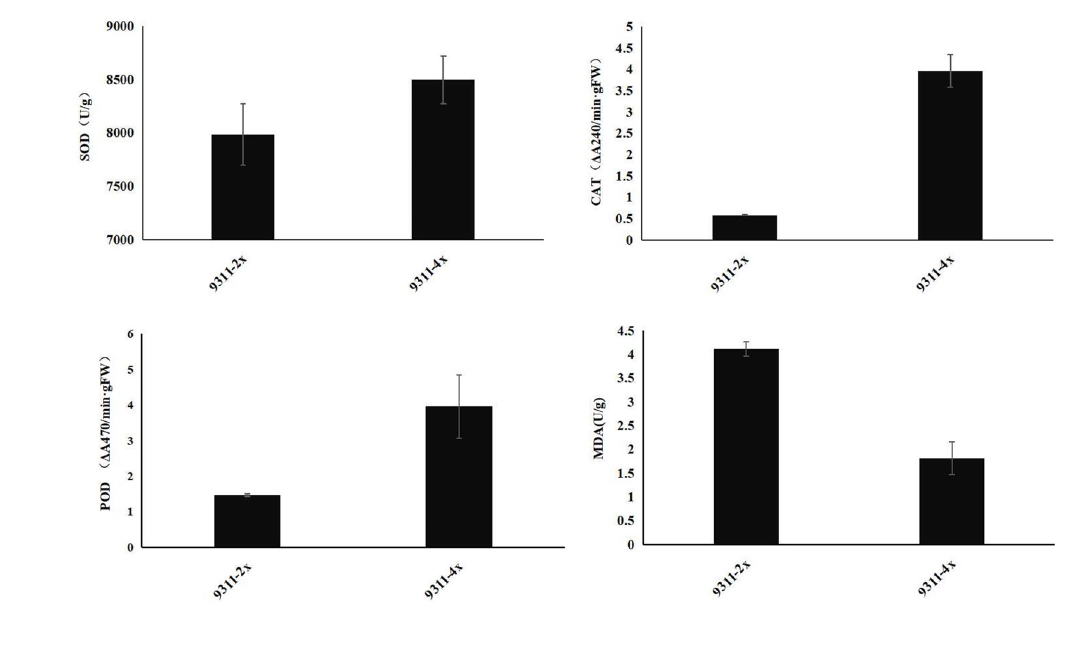
Fig 7. Comparison of antioxidant enzyme activities and malondialdehyde (MDA) content between rice seeds of 9311-2x and 9311- 4x. (a) The enzyme activity of SOD; (b) the enzyme activity of CAT; (c) the enzyme activity of POD; (d) the content of malondialdehyde. Values are the mean ±